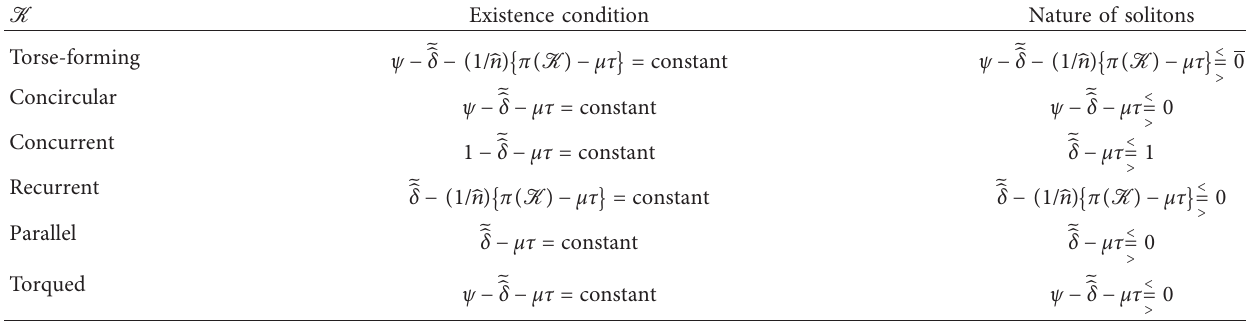
Table 2: Relationship between K , existence condition, and nature of solitons.